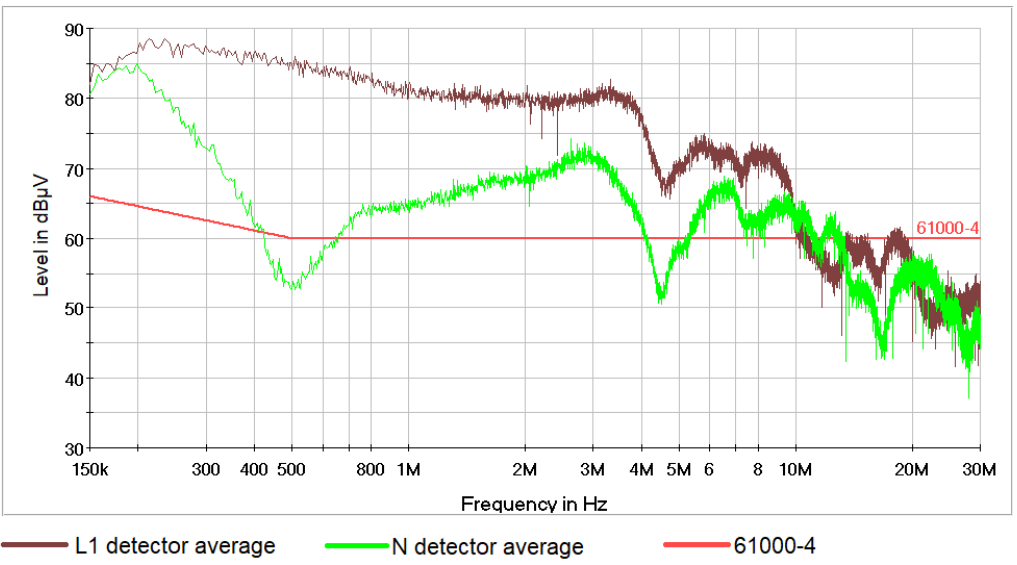
Figure 7. Conducted emissions — ignition system.